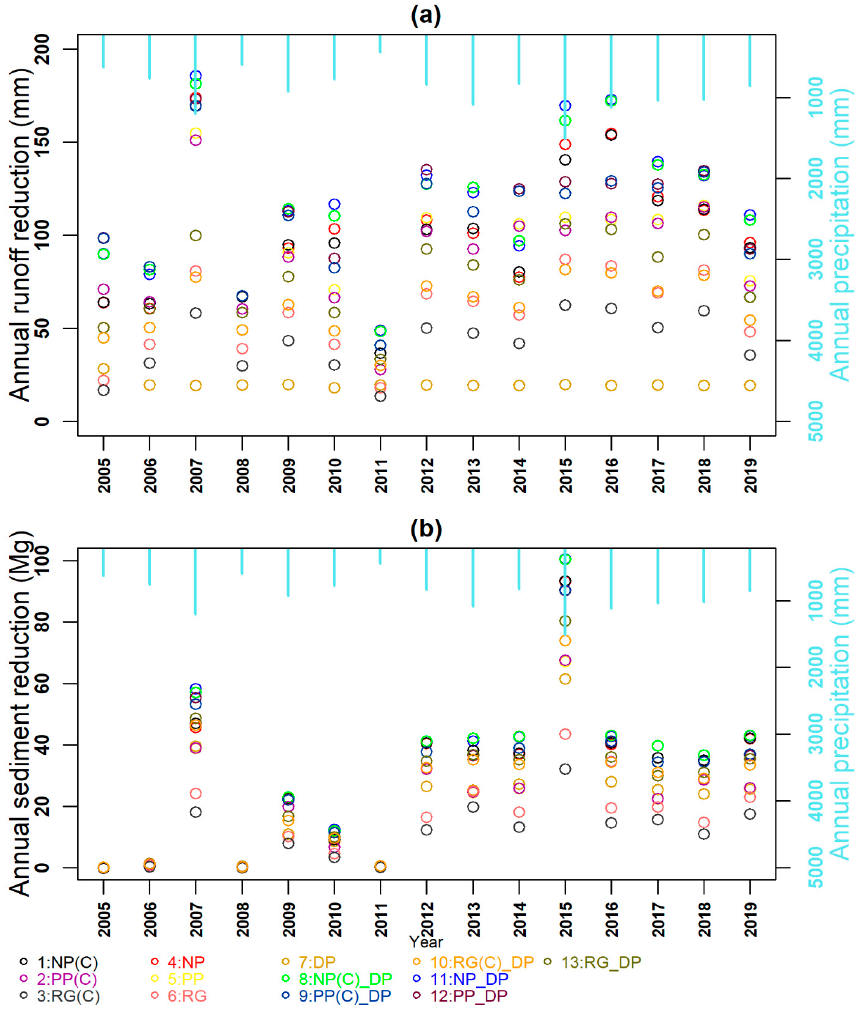
Figure 5. Annual ( a ) runoff depth reduction and ( b ) sediment yield reduction at the watershed outlet resulting from LID scenarios from 2005 to 2019. The LID scenarios had the potential to result in greater reductions in runoff depths and sediment yields during wet years and months than during dry periods. For example, the averages of the reductions in annual runoff depths for the 13 scenarios ranged from 44–65 mm in 2007, 2013, 2015, and 2016, with annual precipitation depths ranging from 1086 mm to 1515 mm. On the contrary, the averages of the reductions in annual runoff depths for the 13 scenarios were 16–31 mm in 2005, 2006, 2008, and 2011, when annual precipitation depths ranged from 441 mm to 760 mm (Figure 5a). Similarly, averages of monthly average sediment loss reductions for the 13 scenarios were 3.43–5.12 Mg in